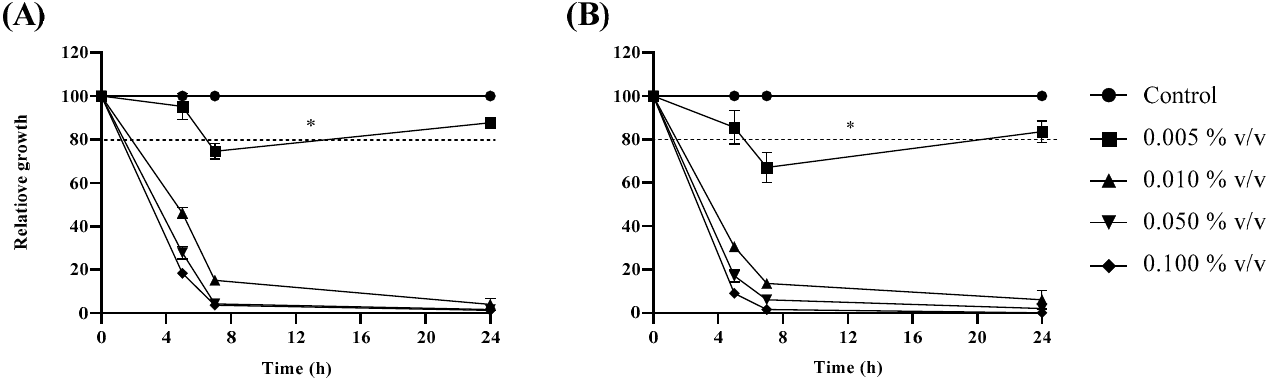
Figure 5. Effect of L. angustifolia free ( A ) and liposome-encapsulated oil ( B ) on planktonic C. auris growth. Values below the dotted line are statistically significant, * p < 0.05 (Holm–Sidak’s test).